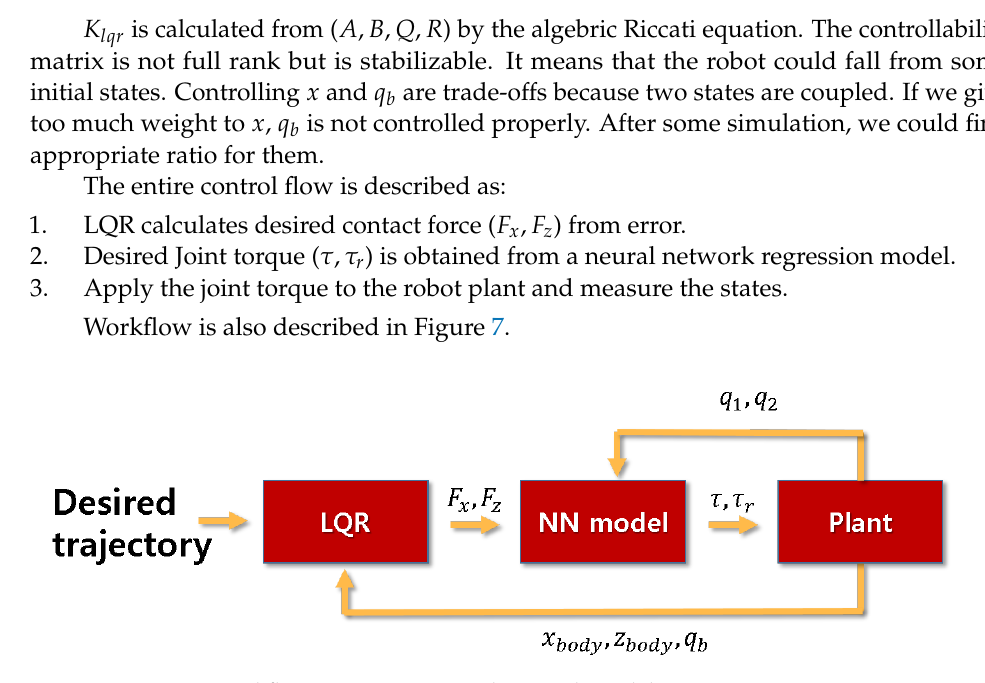
Figure 7. Entire control flow, NN means neural network model.